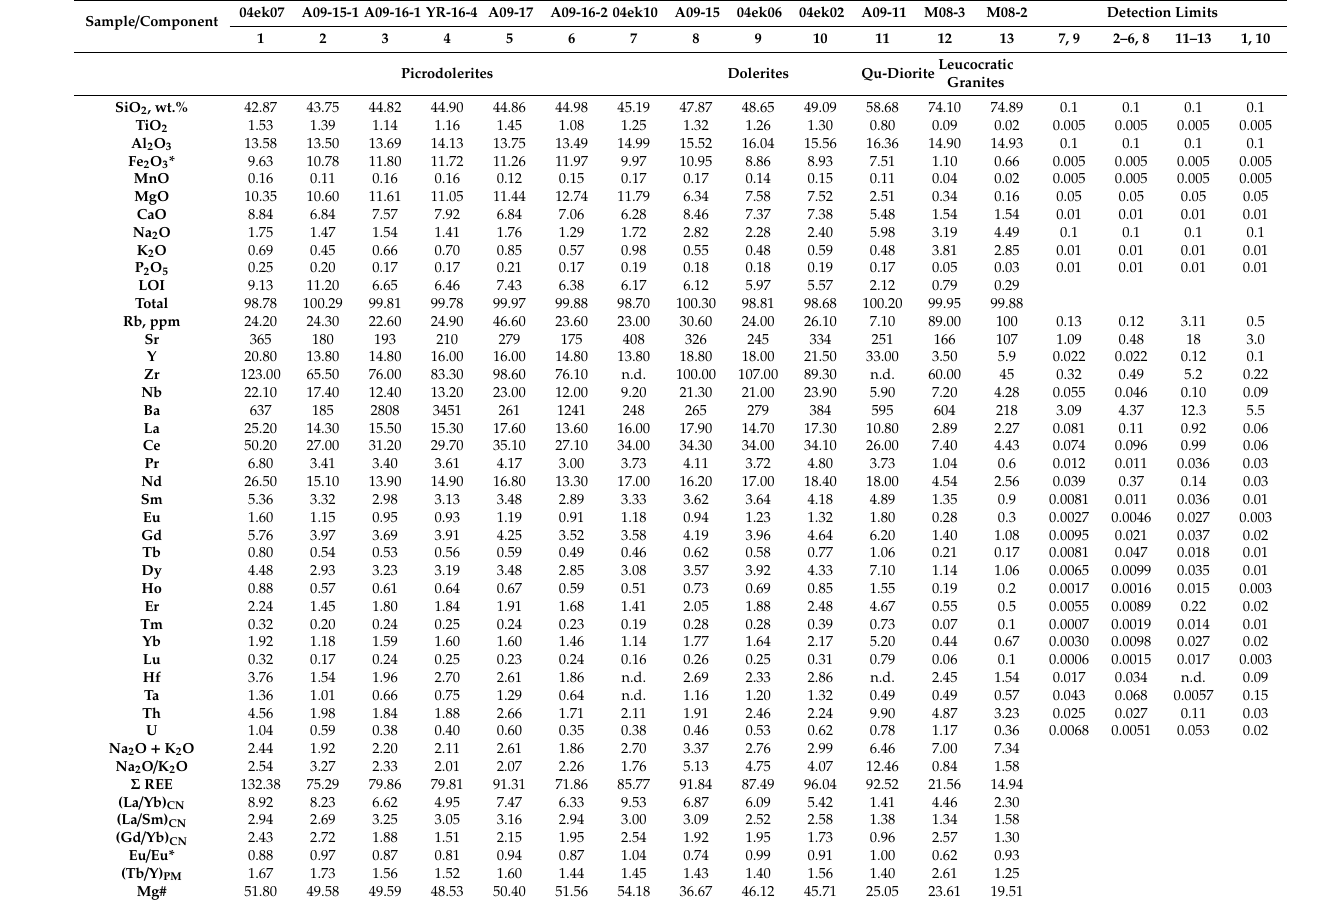
Table 1. Chemical composition of the dike